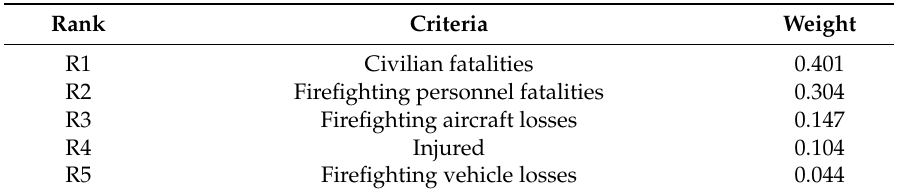
Table A12. Pair-wise comparison reciprocal matrix for the casualties and fatalities fire e ff ects